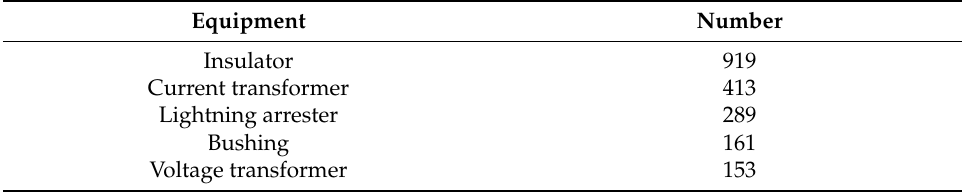
Table 2. Number of each type of equipment in the instance segmentation dataset.